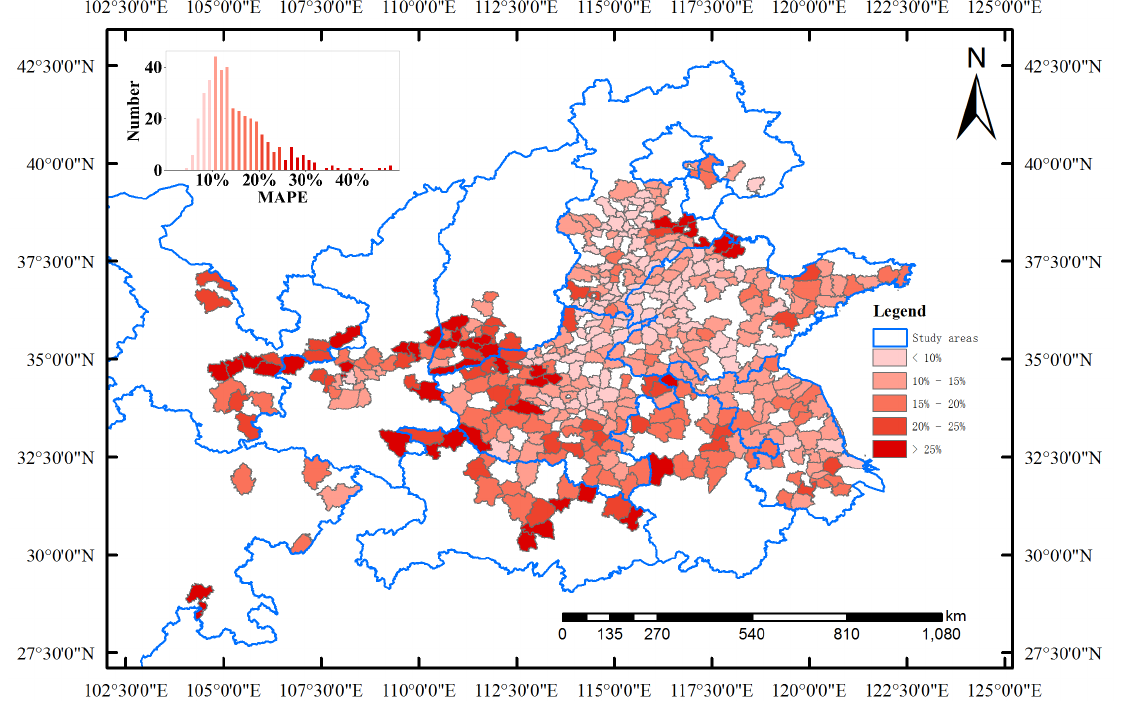
Figure 7. Spatial distribution of the Mean Absolute Percentage Error (MAPE) calculated from the predicted yields of all the years for each county. The inset panel in the upper left is the histogram of MAPE.